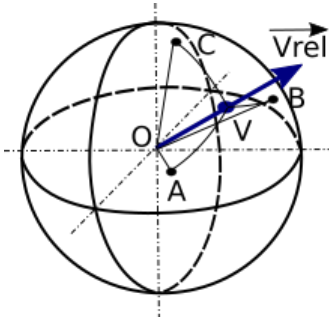
Figure 1. Unit sphere used for the interpolation of force and momentum